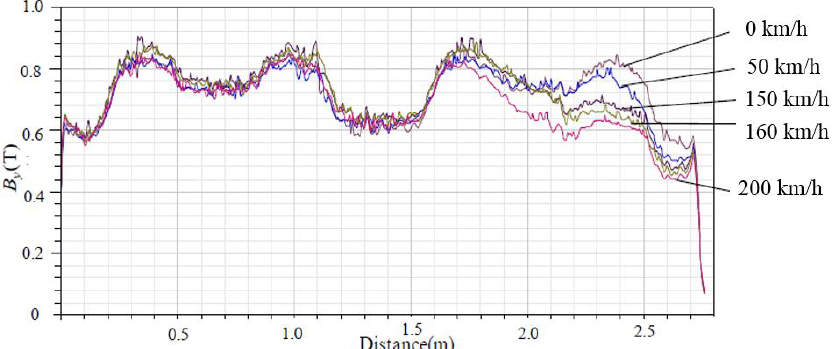
Figure 3. The distributions of air-gap flux density at different speeds over the whole length of the front-end electromagnet module.